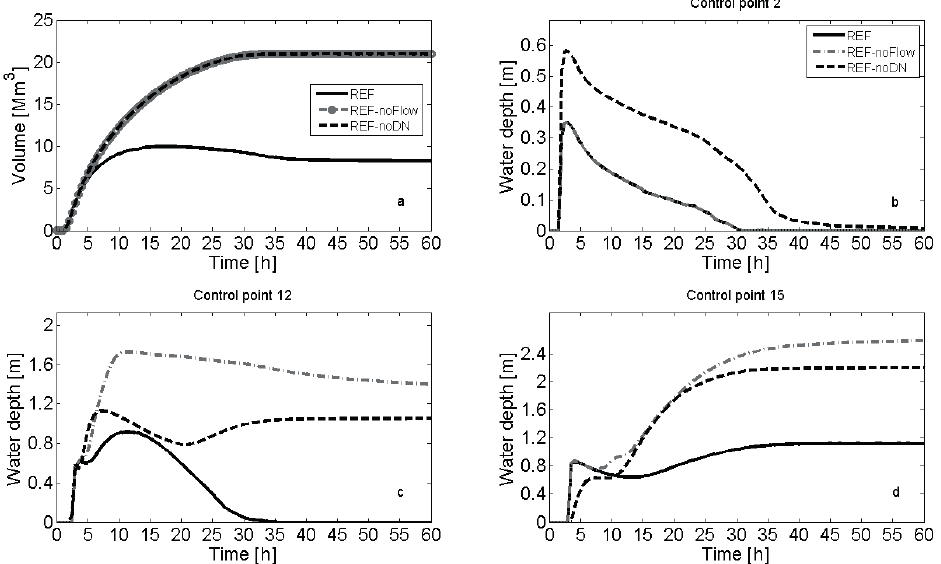
Fig. 3 Panel a: time evolution of the overall flooded volume in the study area. Panels b, c, d: water depth evolution for different configurations at checkpoints number 2, 12 and 15, respectively (see also Fig.